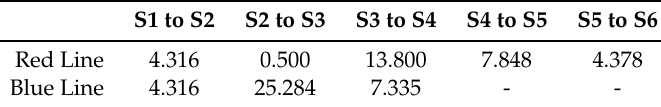
Figure 3. Schematic representation of the case study. Table 1. Length of the different line segments in